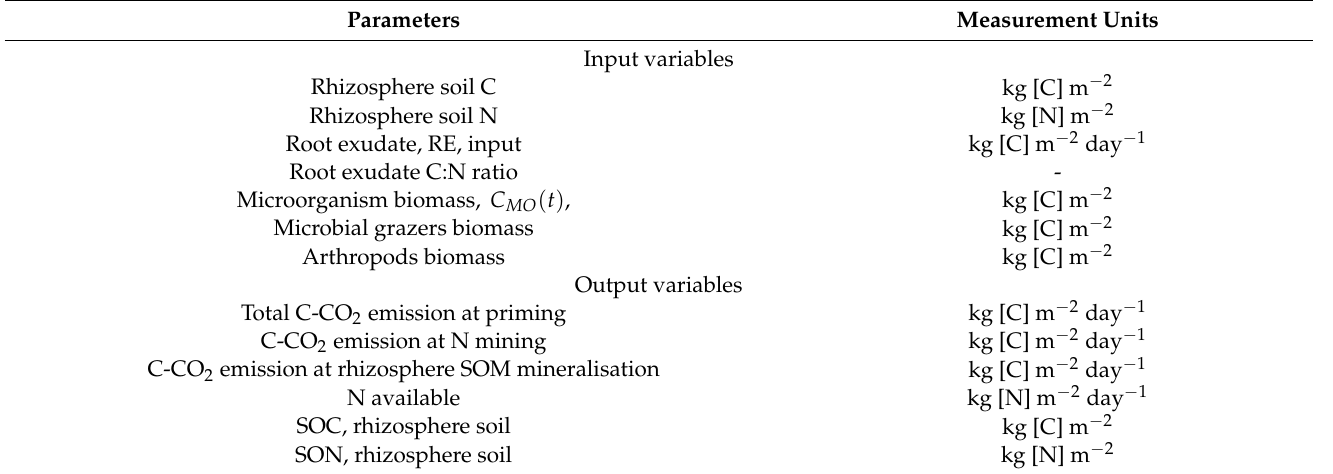
Table 1. Model input and output variables.